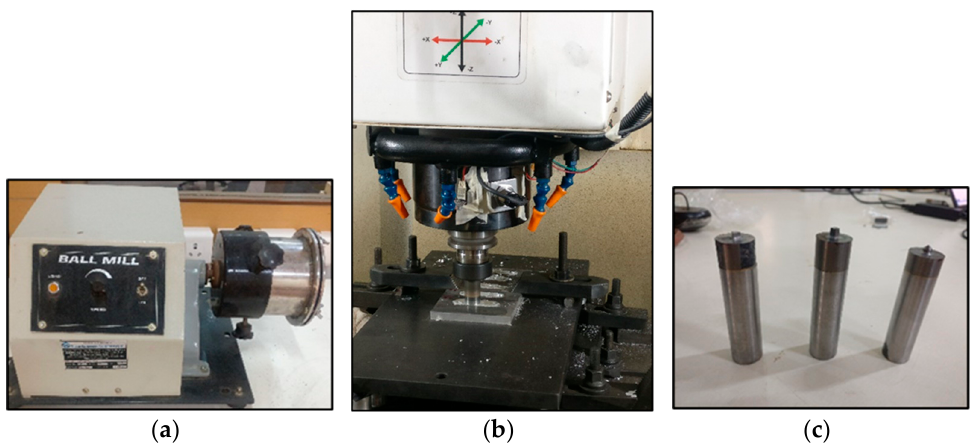
Figure 1. ( a ) Ball milling machine for preparing the reinforcement mixture; ( b ) FSP set up for preparing surface composites; ( c ) tools used for composite fabrication.